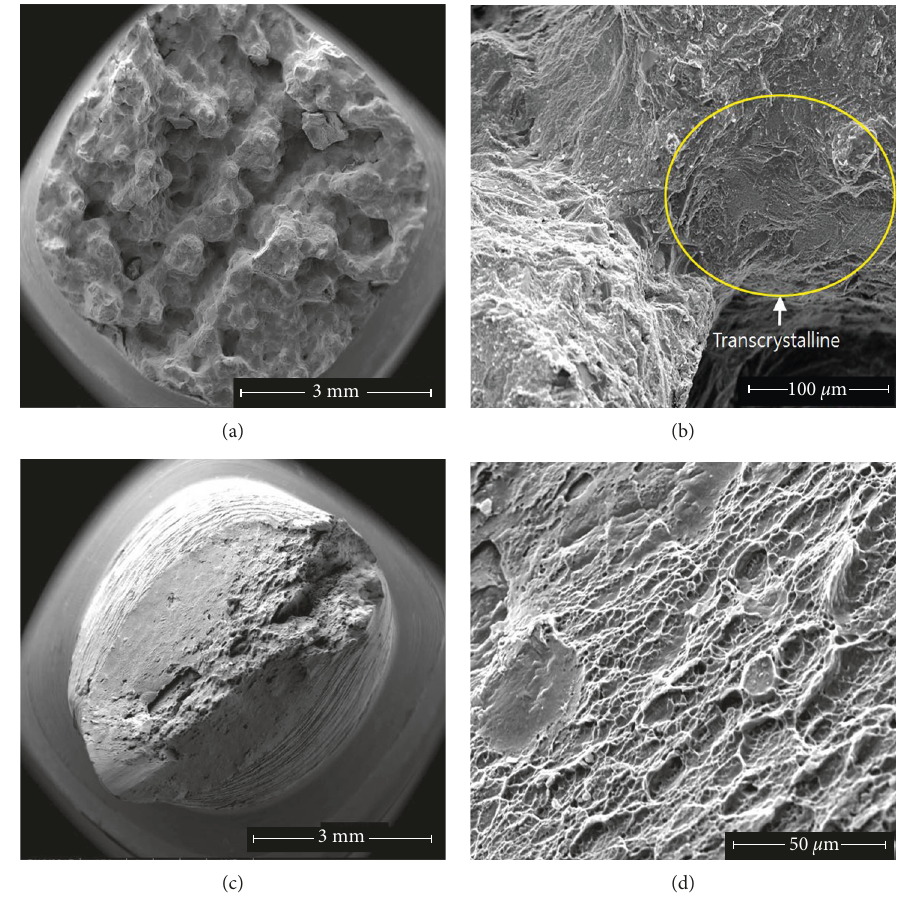
Figure 11: Fracture surfaces of crept specimens under stresses of 400 MPa (a, b) and 300MPa (c,